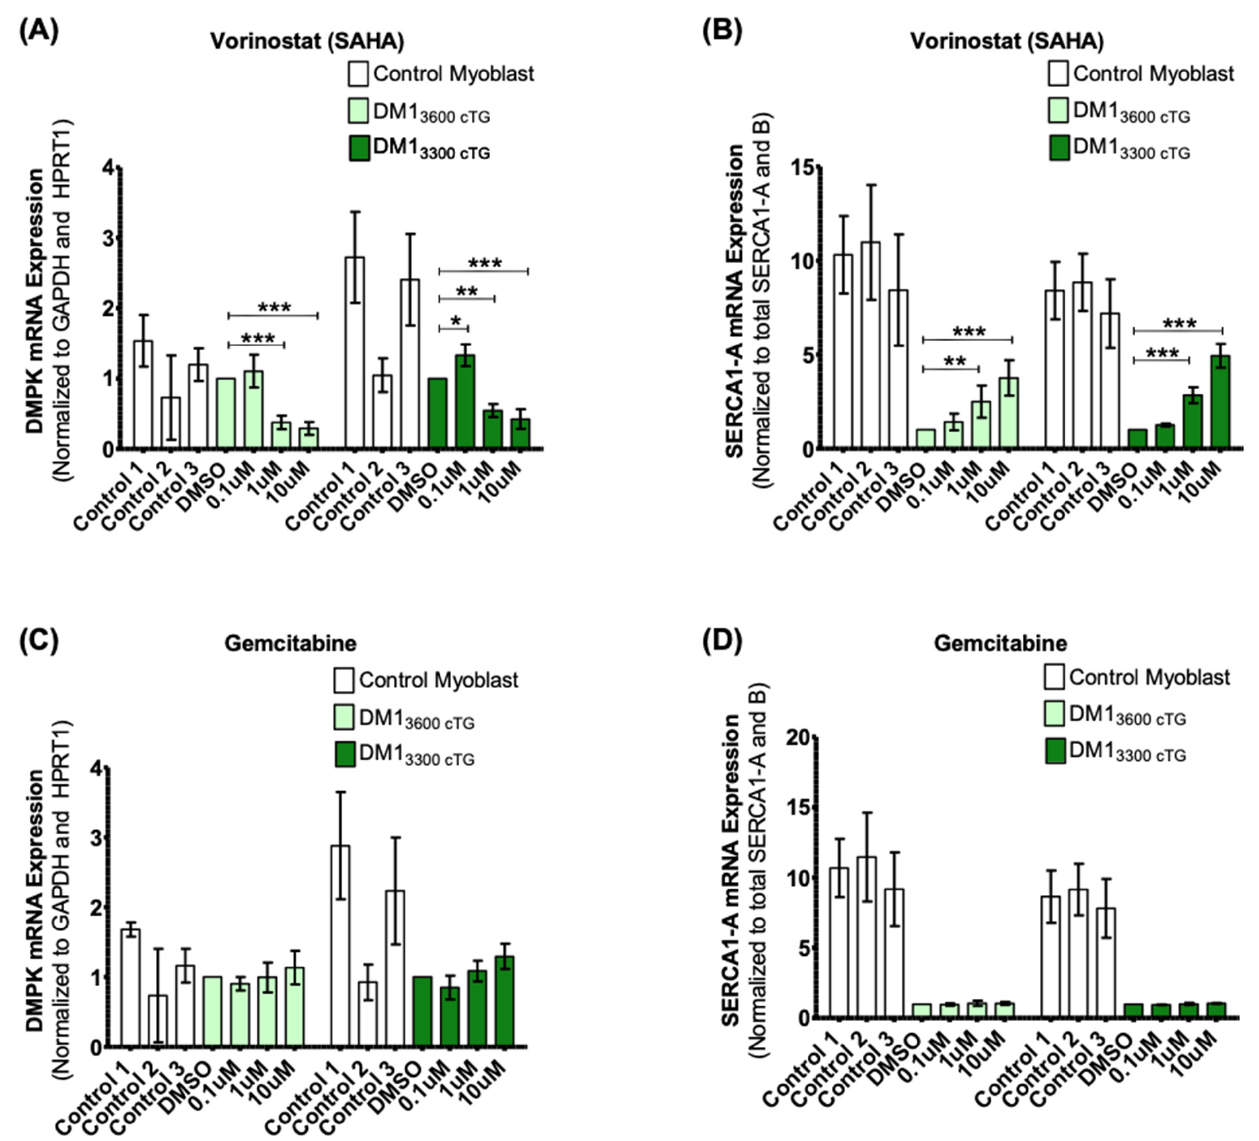
Figure 3. Vorinostat (SAHA), but not gemcitabine, reduced DMPK mRNA levels and rescued the SERCA1-A splice product in both DM1 3600CTG and DM1 3300CTG differentiated myoblasts. Control DM1 3600CTG and DM1 3300CTG myoblasts were serum-starved in 6-well plates for 7 days. DM1 cells were treated with DMSO alone or 0.1, 1 or 10 µM of ( A , B ) vorinostat (SAHA) or ( C , D ) gemcitabine; control myoblasts were treated with DMSO and used for baseline quantification in unaffected cells. RNA was extracted (RNeasy micro kit, Qiagen) and reverse-transcribed to cDNA (iScript Advanced RT kit, Biorad). RT-qPCR was performed (iQ Sybr green supermix, Biorad) to assess mRNA levels ( n = 6, two-way ANOVA; error bars represent SD). * p < 0.05, ** p < 0.01, *** p < 0.001.